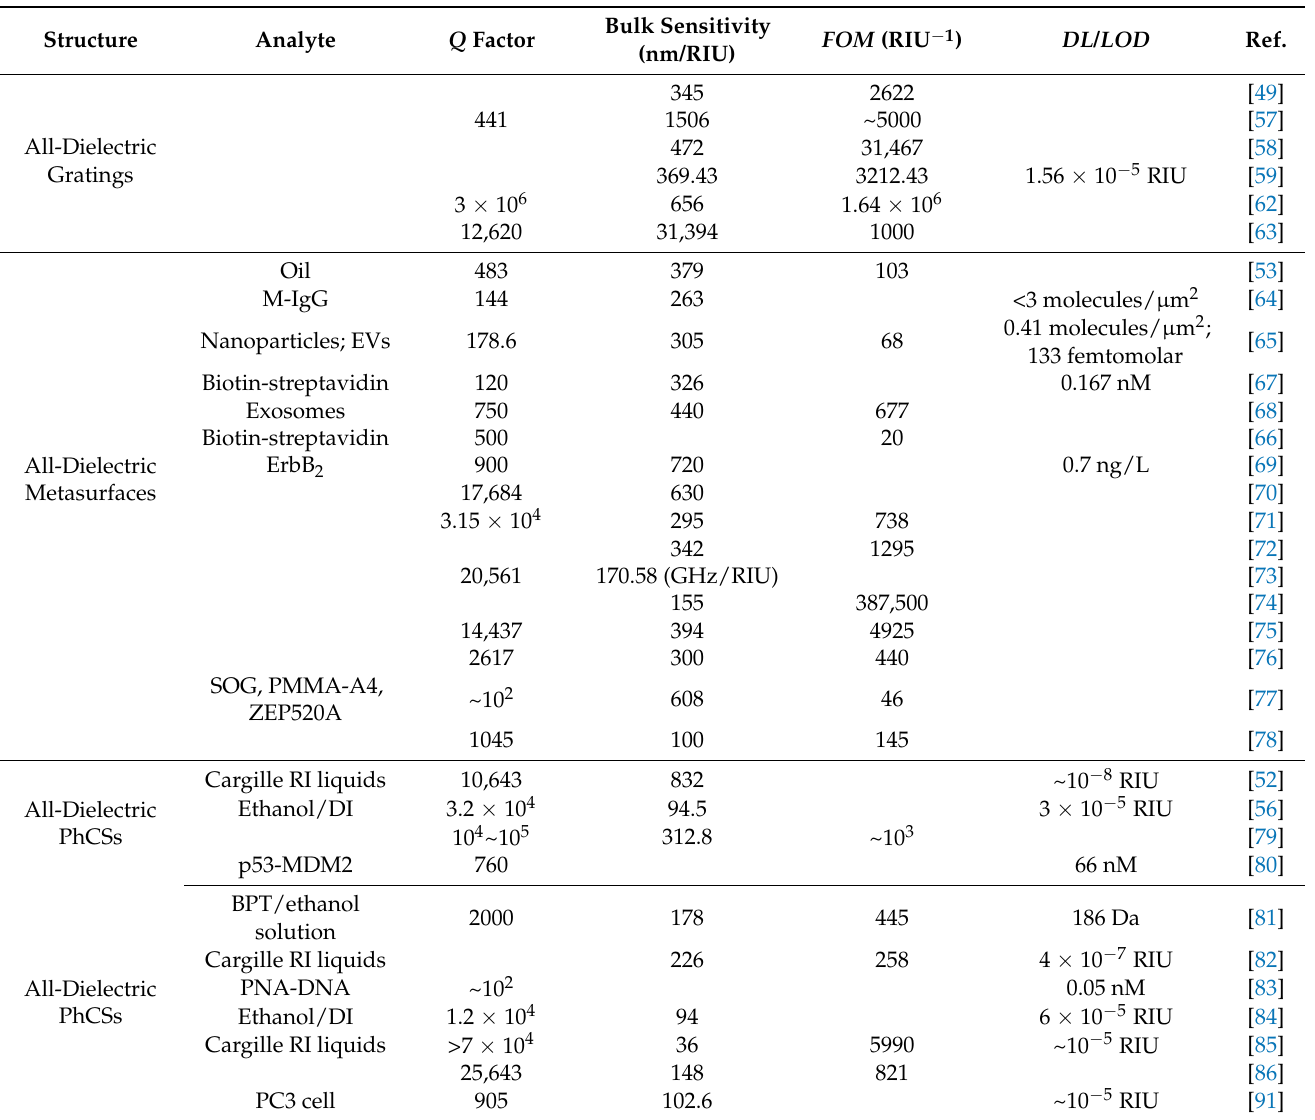
Table 1. Summary of different label-free BICs optical